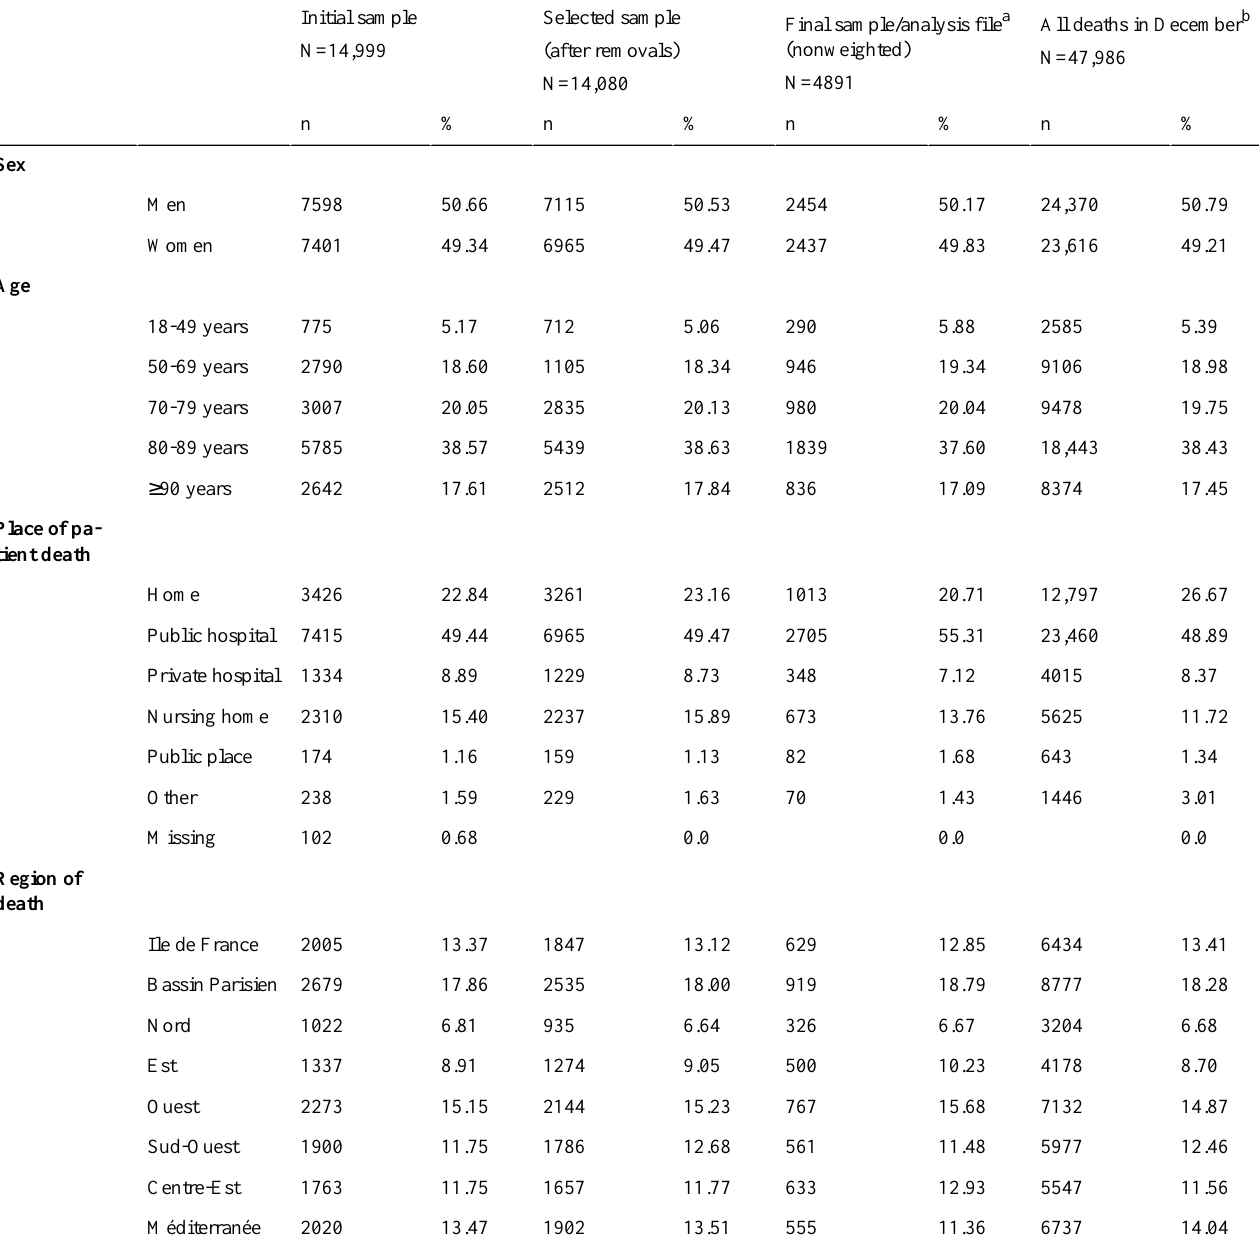
Table 2. Sociodemographic characteristics of the sample of deaths: initial sample, selected sample, and returned questionnaires (%).